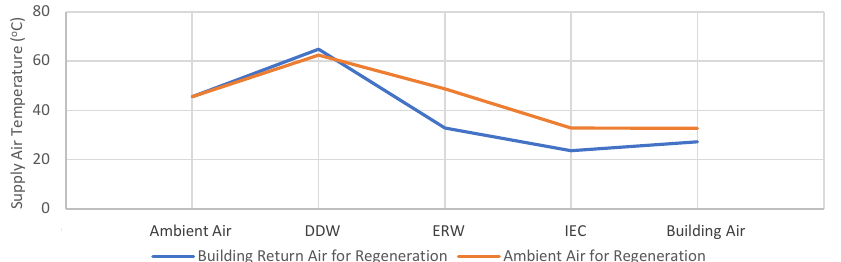
Figure 11. Comparison of the supply air temperatures through each component of the two different systems.